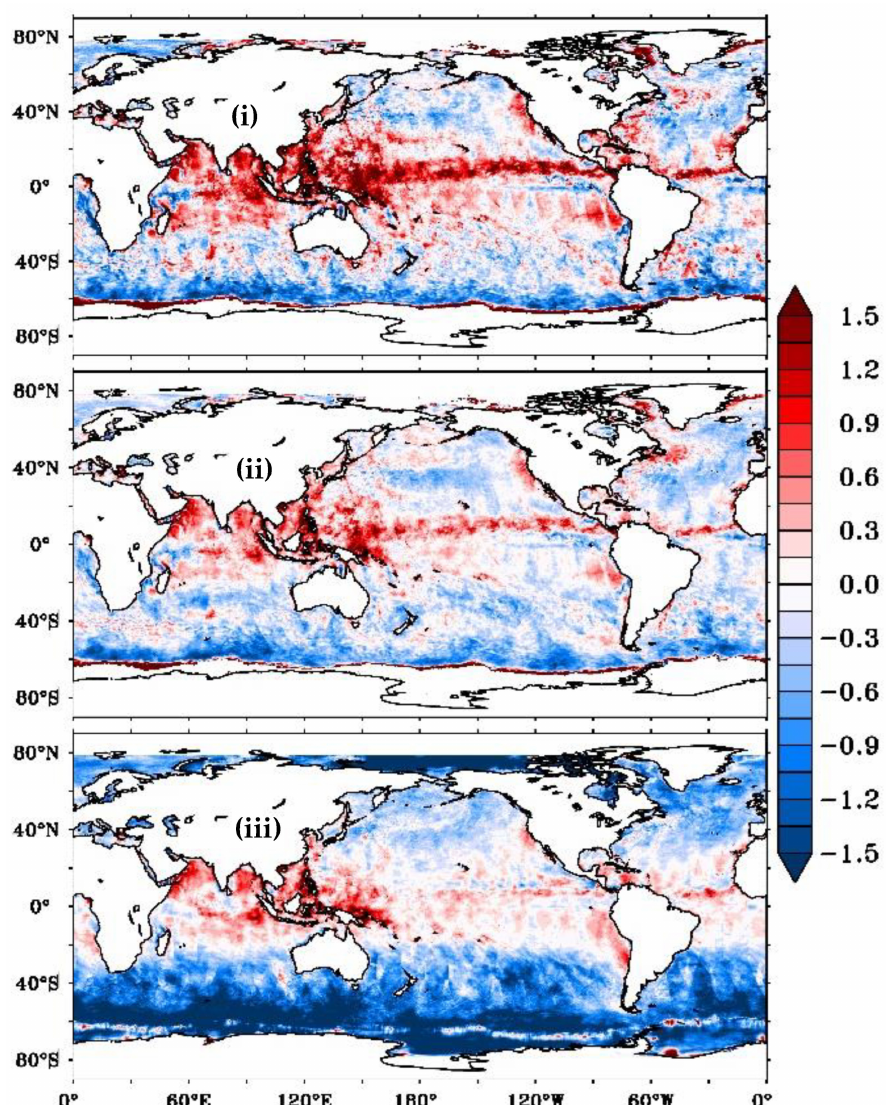
Figure 9. The spatial distribution of bias in wind speed (m/s) between CCMP wind speeds and ( i ) SCATSAT-1 L2B wind speed (top panel), ( ii ) Particle filter based reanalysed wind speed (middle panel) ( iii ) SCATSAT-1 L4AW wind speed (bottom panel) during July